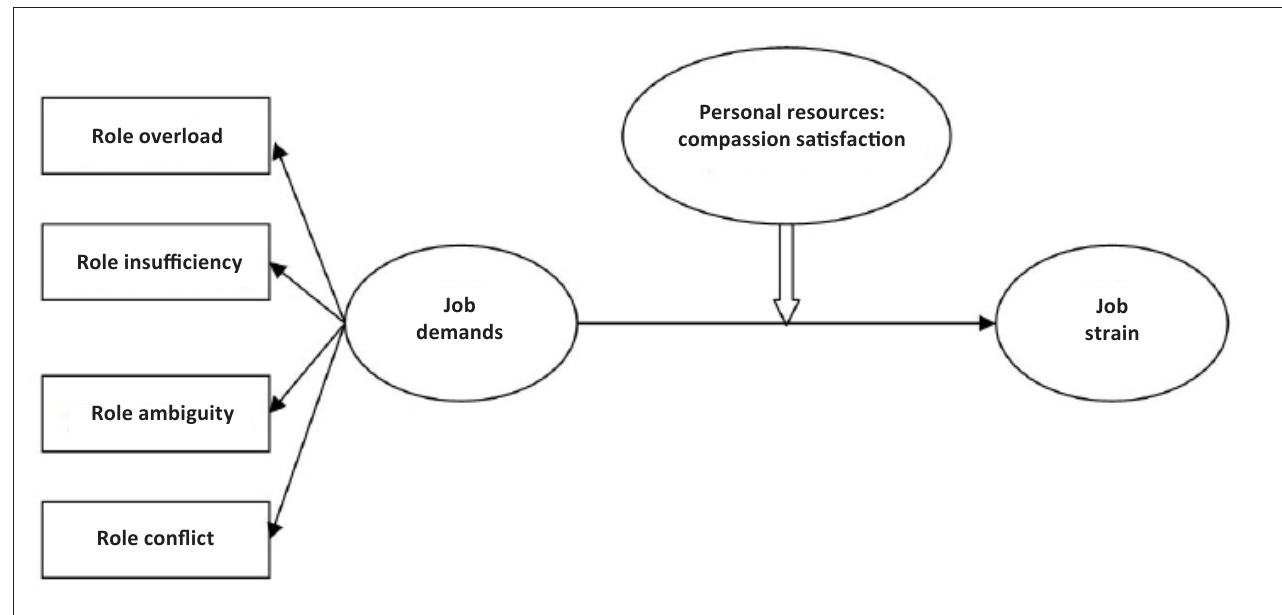
FIGURE 1. Theoretical model used in the present